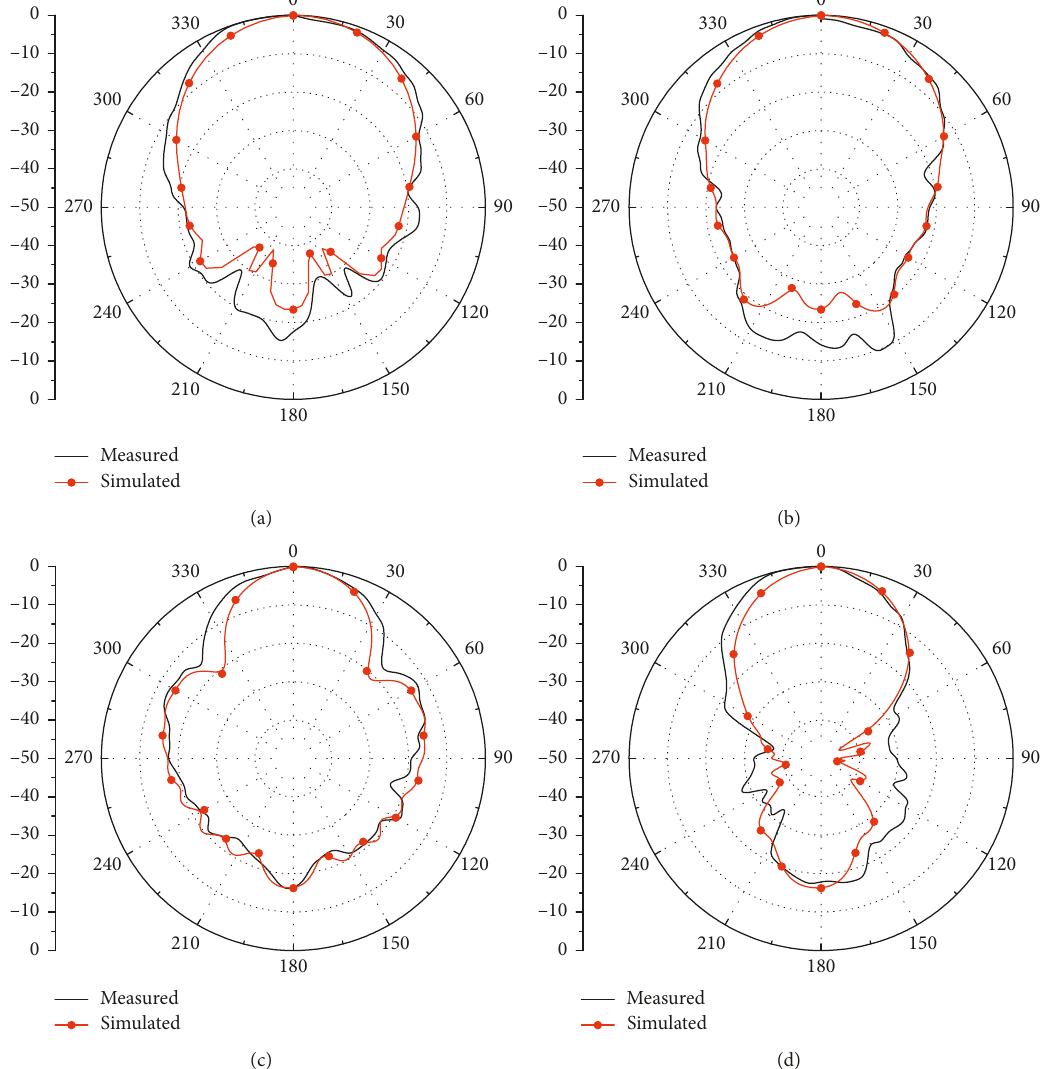
Figure 10: Millimeter-wave horn antenna radiation pattern. (a) E -plane at 17.5GHz. (b) H -plane at 17.5GHz. (c) E -plane at 24 GHz. (d) H -plane at Figure 7. A discrepancy at 2.56 GHz in the front-back region for E -plane is observed in Figure 7(a). Regarding the main lobe, the measured and simulated results have consistently been shown for all frequencies and planes.